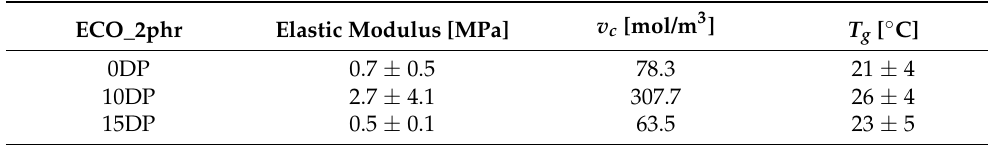
Figure 3. tan δ ( a ) and storage modulus ( b ) for UV-cured samples obtained with different amounts of DP. Table 2. Results obtained by DMTA analysis for samples with different amount of DP. T g was calculated as the maximum of tan δ . v c calculated by Equation